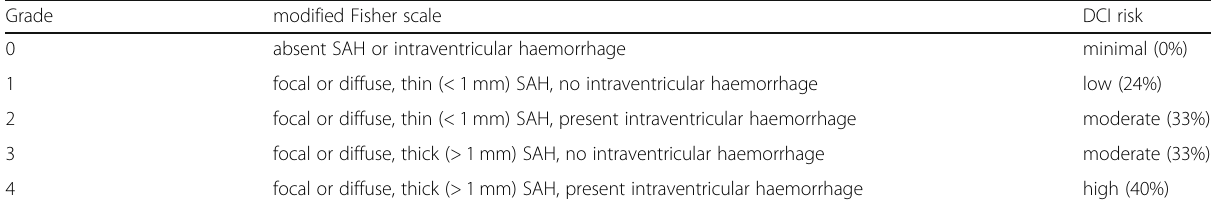
Table 2 Grading based on CT-scan as defined by the (modified) Fisher scale and associated risk for delayed cerebral ischaemia (DCI)